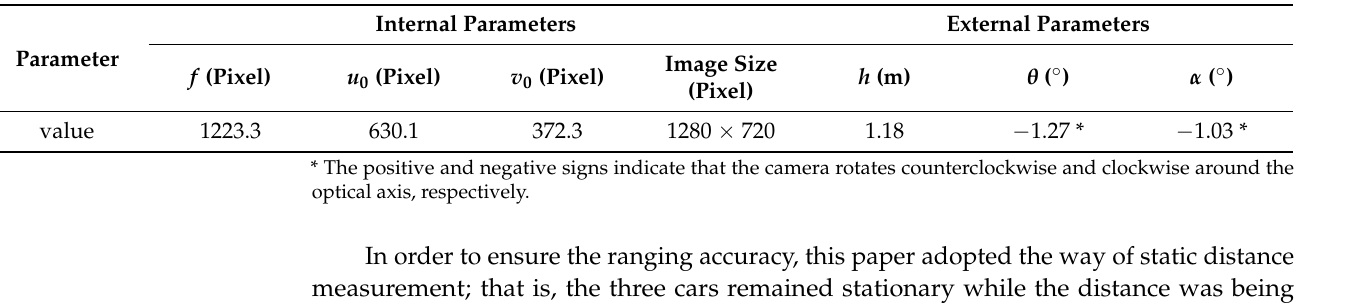
Figure 8. One of the experimental scenes. Table 3. Parameters of on-board camera.